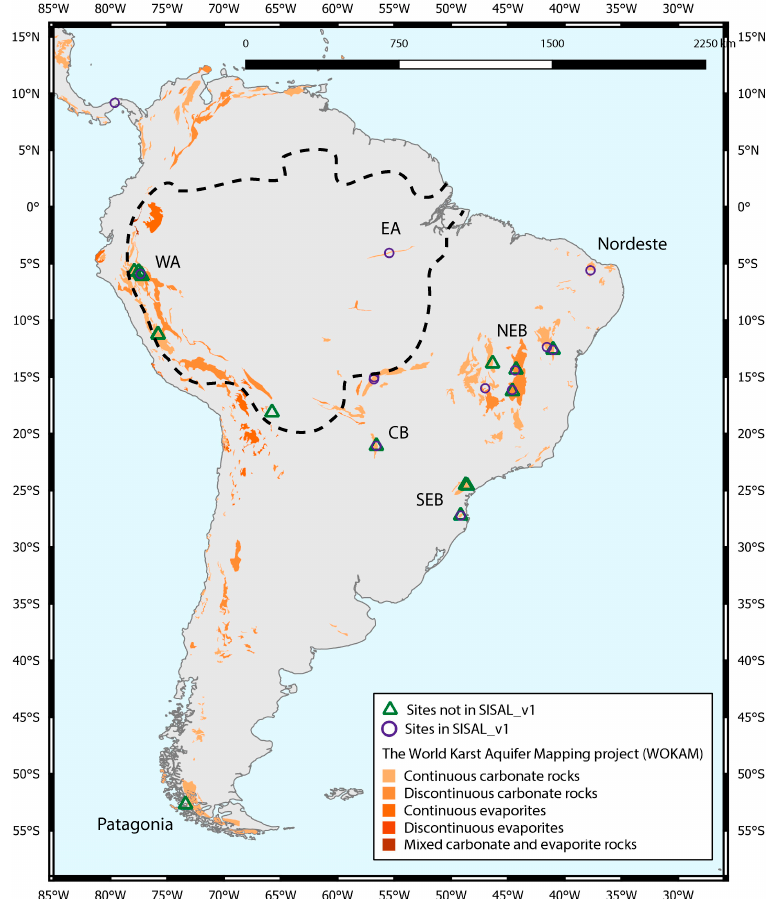
Figure 1. Map showing the distribution of carbonate and evaporite rocks in South America, provided by the World Karst Aquifer Mapping project (WOKAM [6]). Green triangles indicate study sites in the region identified by the Speleothem Isotopes Synthesis and Analysis (SISAL) working group but not included in the current version of the database, while purple circles show sites that are already in SISAL_v1 [3]. Specific information on sites and entities is given in Table 1. The dashed envelope frames the Amazon basin while acronyms and names show specific regions mentioned in the text: EA, eastern Amazonia; WA, western Amazonia; CB, central Brazil; NEB, northeastern Brazil; SEB, southeastern Brazil.